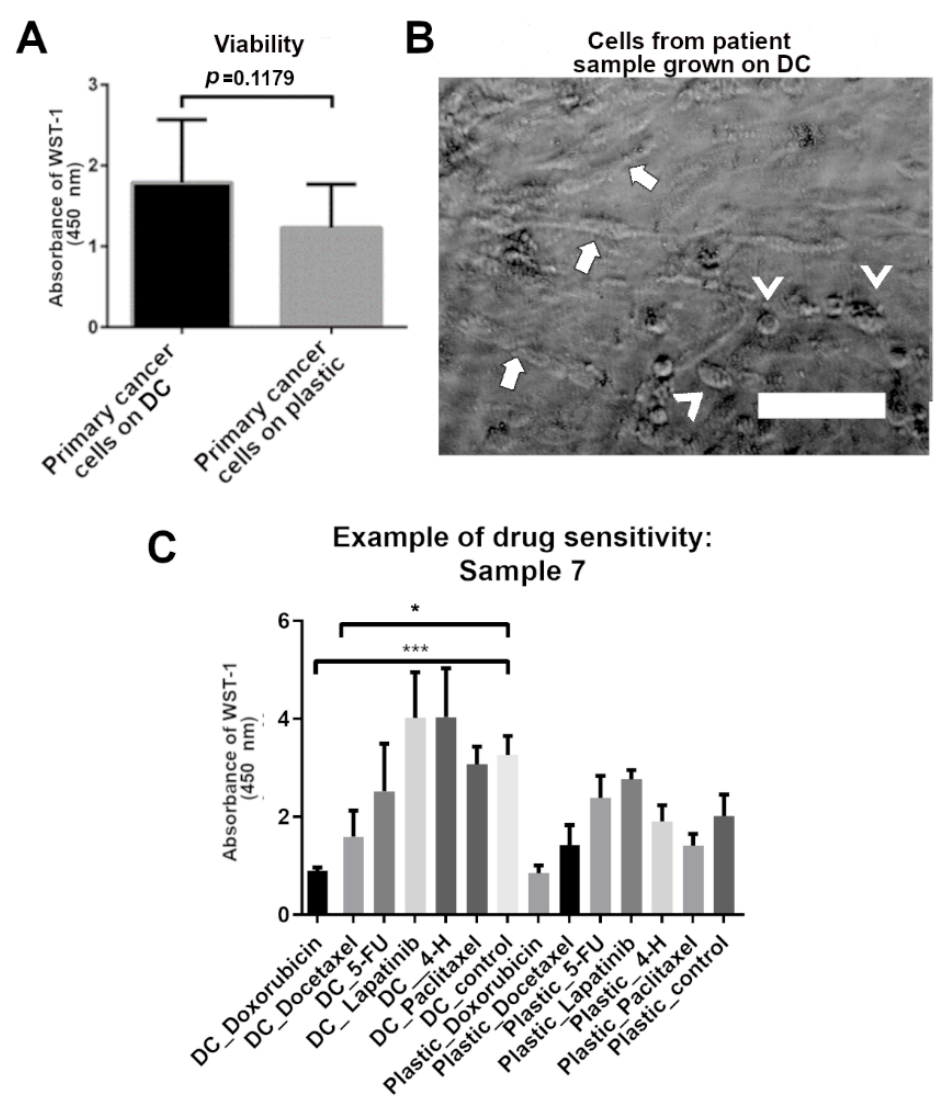
Figure 4. Primary cancer cells on decellularized in vitro capillaries (DC). ( A ) WST-1 analysis results of the proliferation of all patient-derived cells on DC and on plastic. No significant differences were seen between growth surfaces; however, the trend is that patient-derived cells grown on DC have higher viability. Mean ± SD is shown. ( B ) A phase-contrast image of one patient sample, sample 7, showing “network” pattern in the culture (marked with arrows). Clusters formed by patient-derived cells are marked with arrowheads. Scale bar 100 µ m. Imaged with Cell-IQ. ( C ) Exemplary image of the drug sensitivity of sample 7 showing the results with only the highest concentration of drugs tested. When cultured on plastic, the cells did not show sensitivity towards any of the drugs utilized in the study. When cultured on DC, the cells showed sensitivity to doxorubicin (6 µ M) and docetaxel (3 µ M). *** p ≤ 0.001, * p ≤ 0.05. 5-FU = 5-fluorouracil, 4-H = 4-hydroperoxycyclophosamide (in vitro active metabolite of